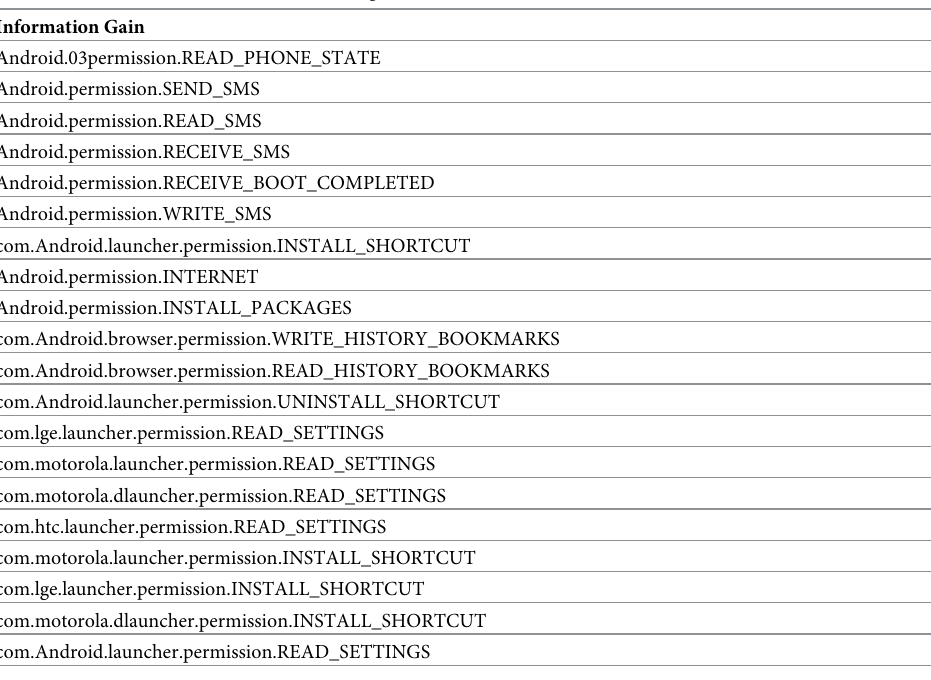
Table 7. 20 features selection of information gain.